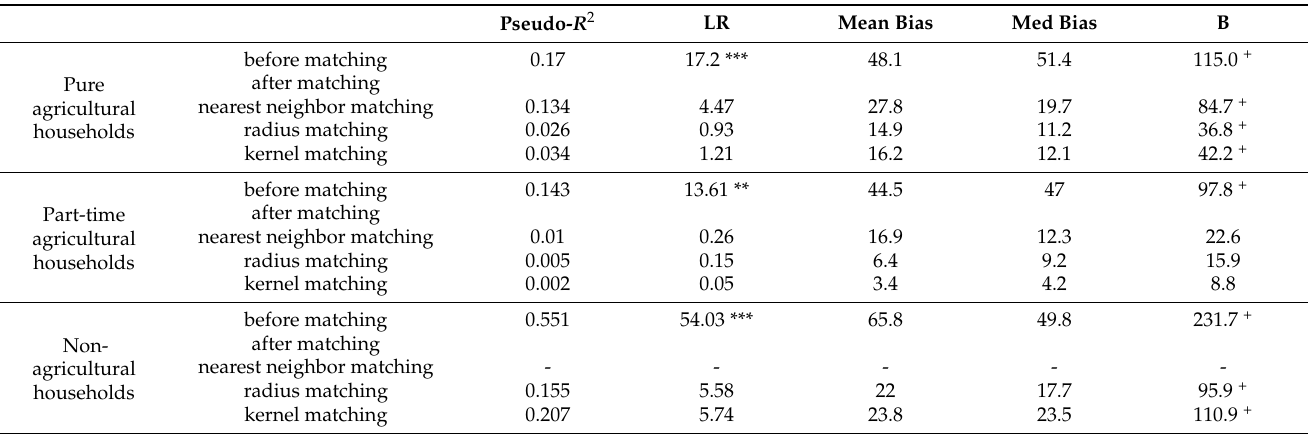
Table 12. The results of balance test before and after